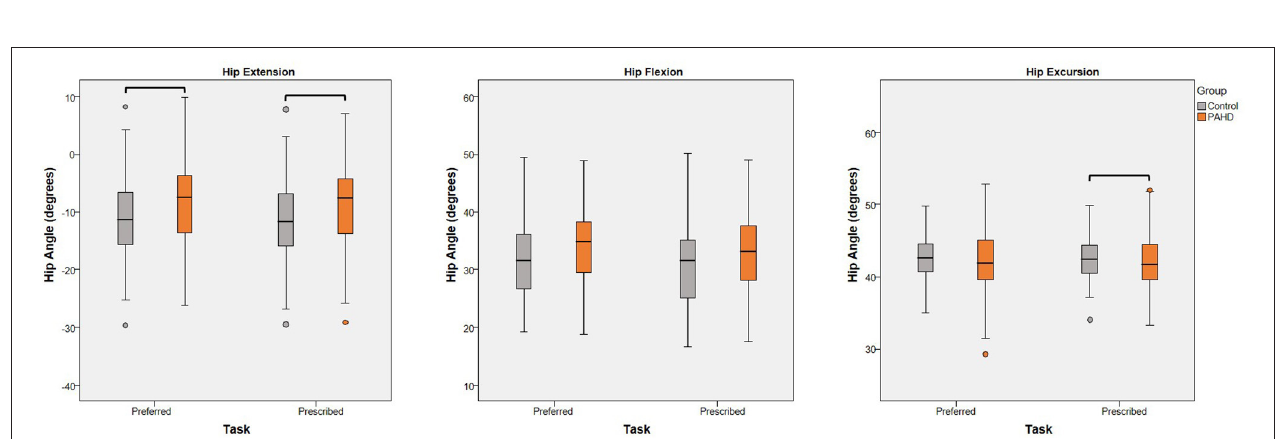
Frontiers in Sports and Active Living |